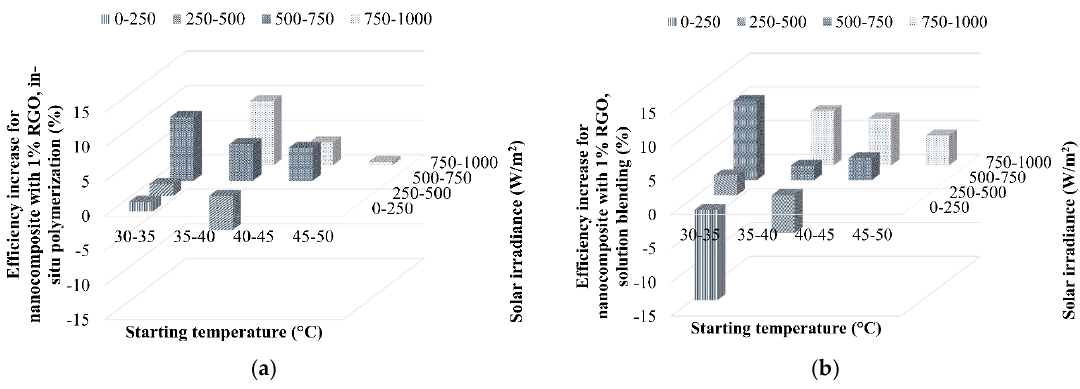
Figure 19. Increment of efficiencies with 1% RGO prepared by ( a ) in situ polymerization and ( b ) solution blending.